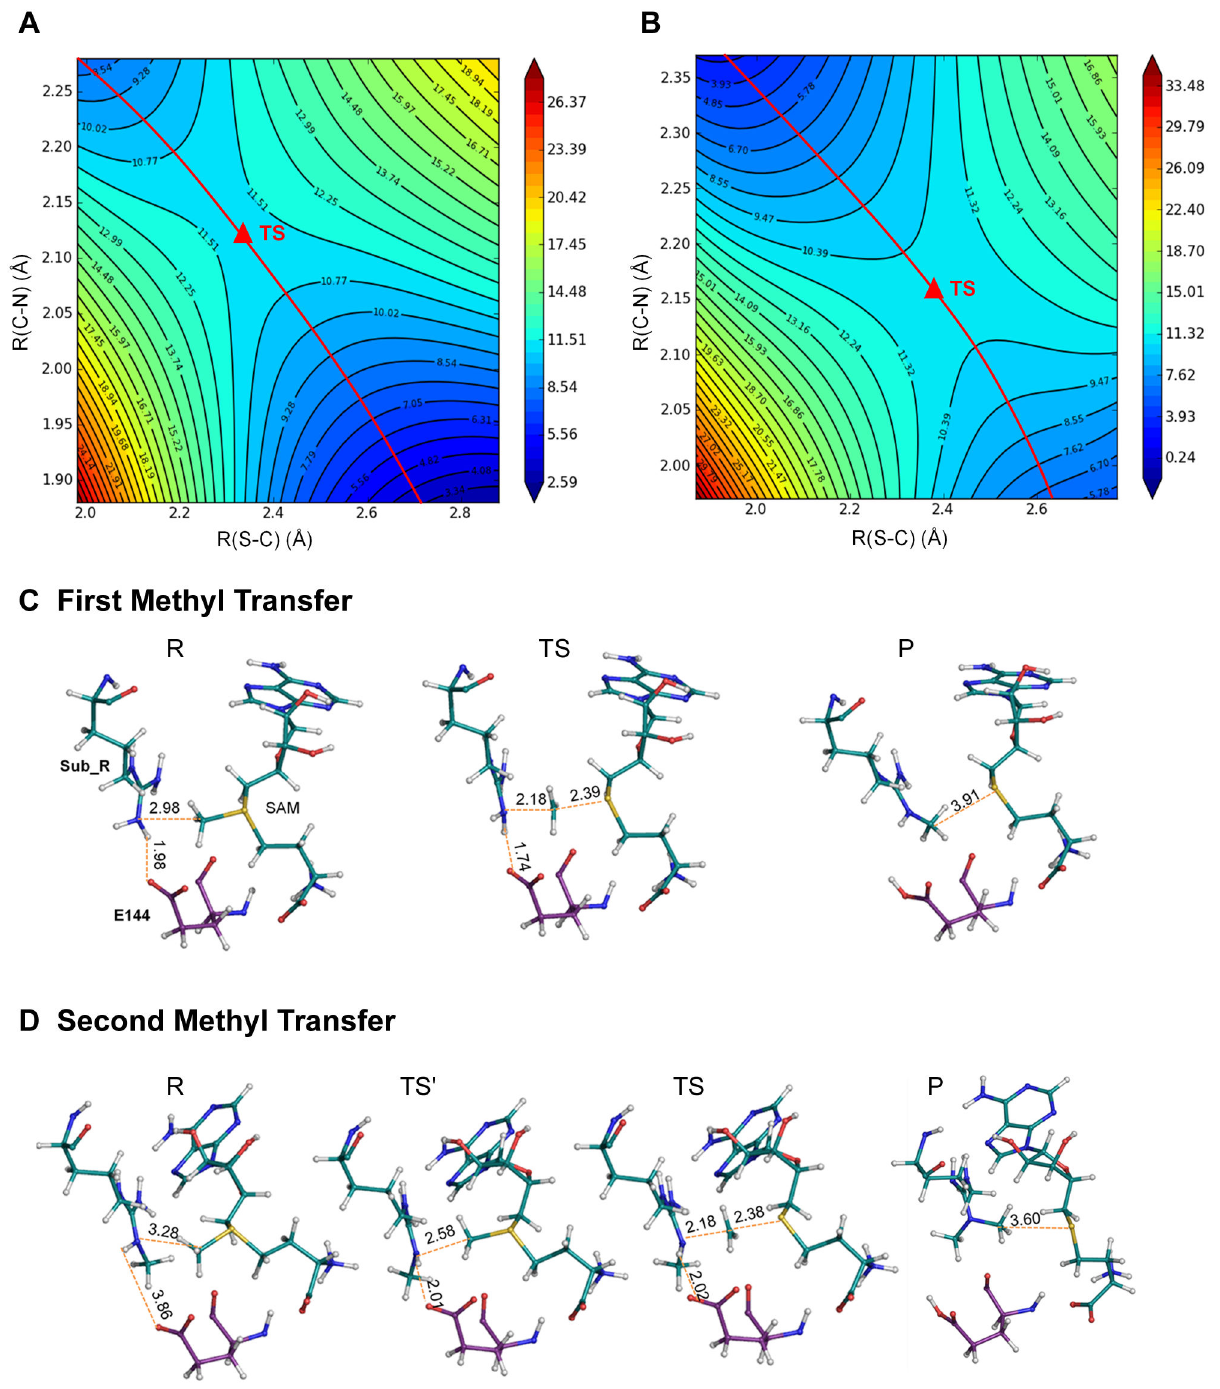
Figure 2. Potential Energy Surface of the first (A) and second (B) methyl transfer. Only the states adjacent to TS were included in the contour plot. Structure of the reactant (R), S methyl transfers.